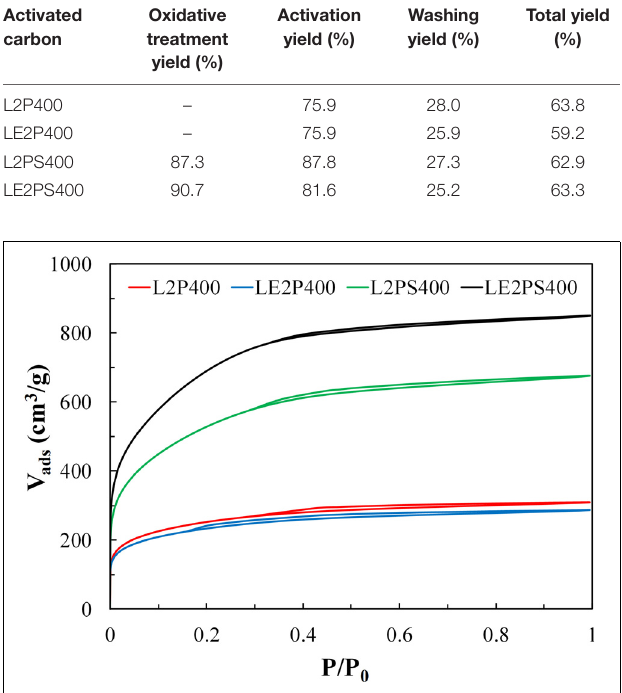
FIGURE 6 | N 2 adsorption-desorption isotherms obtained at –196 ◦ C of the different activated carbons obtained at 400 ◦ C and with H 3 PO 4 to lignin mass ratio of 2.